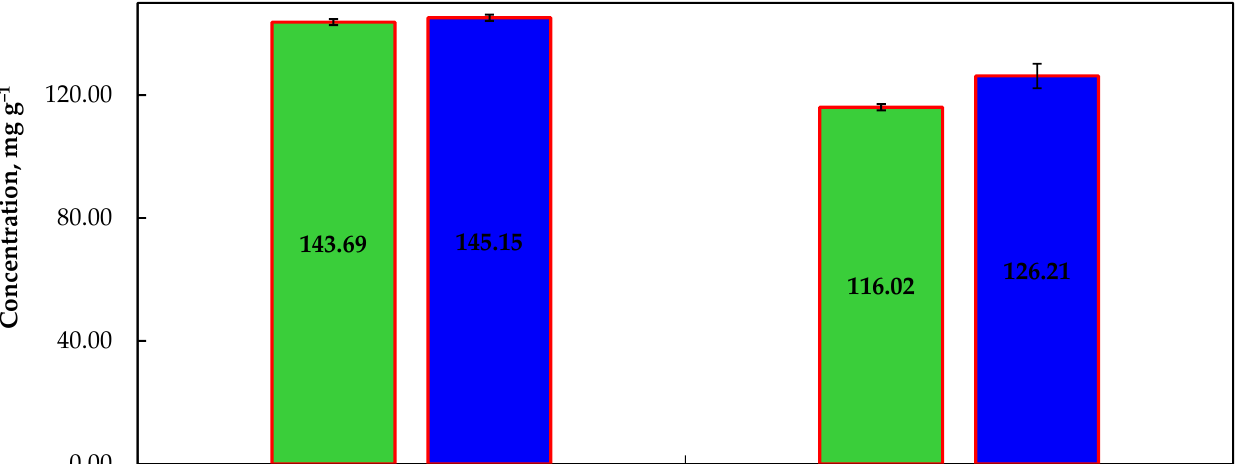
Figure 4. The amount of trans -ferulic acid and trans - iso -ferulic acids in the dry fraction obtained after EtOH evaporation and in the final fraction after MeOH removal, mg g −1 .